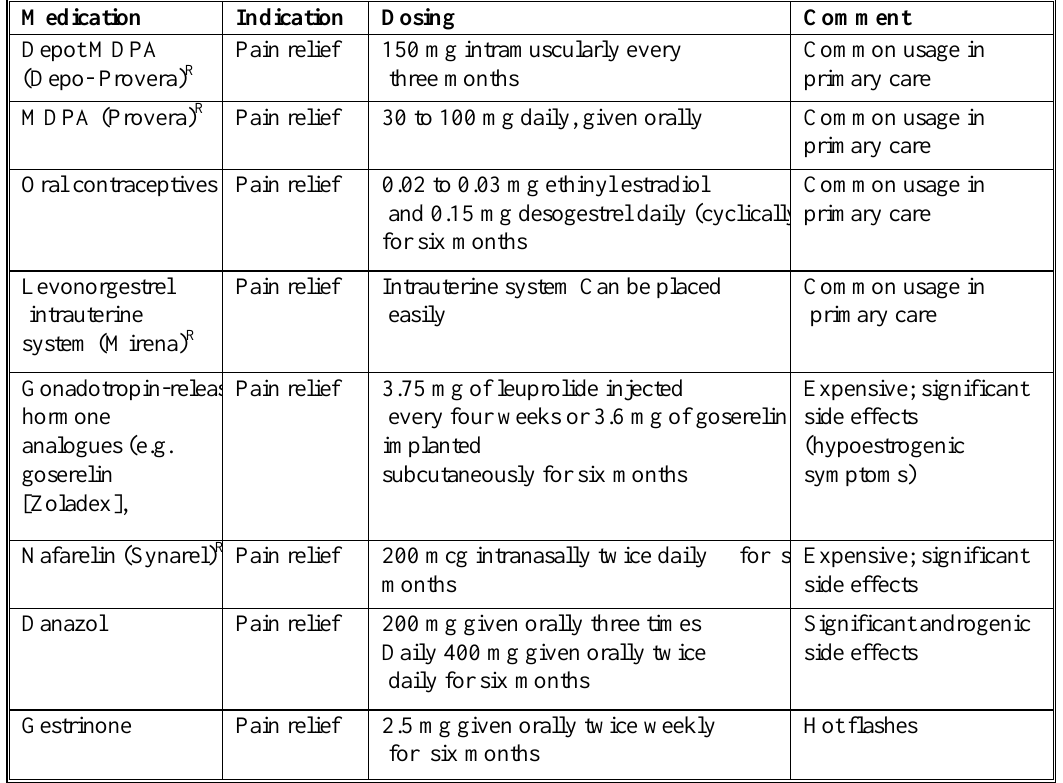
Table (2): Hormonal Treatment for Endometriosis (20) .